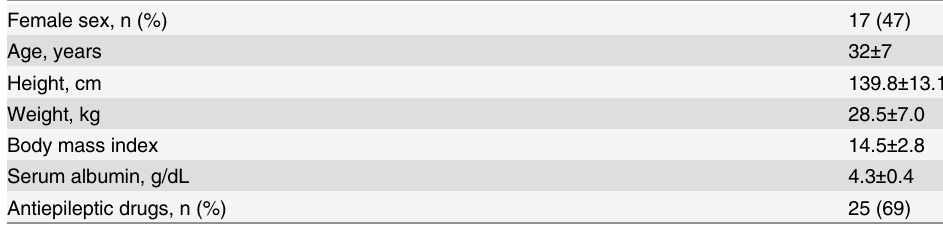
Table 1. Clinical characteristics in all study participants (n = 36).